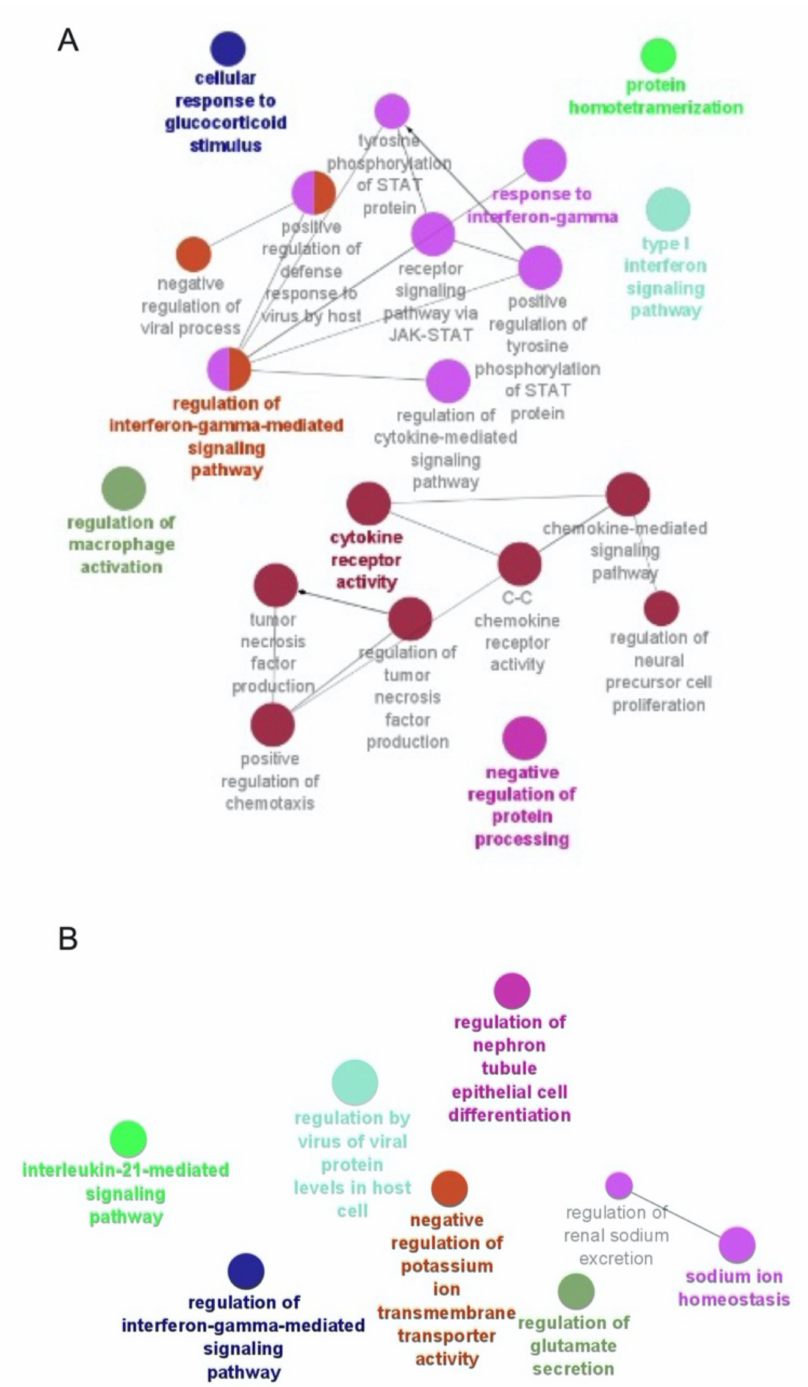
Figure 7. GO term enrichment analysis. The enriched functionally grouped networks of Biological Process category GO terms associated with deregulated genes from monocytes ( A ) and lymphocytes ( B ). The network of functionally grouped GO terms is built in Cytoscape v3.9.0 using the plugin ClueGO v2.5.8. The nodes are representative functional group GO terms and the edges are the associations based on a kappa score, as calculated in ClueGO. Different colors signify different GO terms’ functional groups. Only nodes with a p -value ≤ 0.05 are represented in the